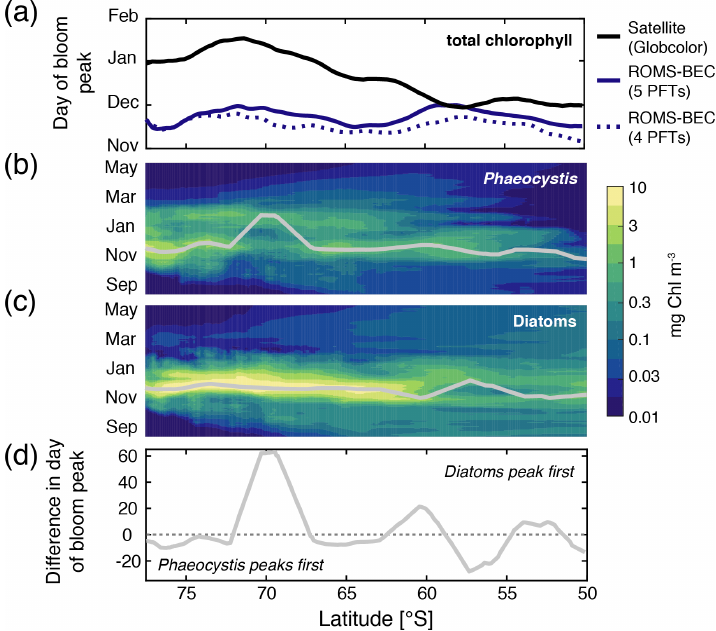
Figure 3. Hovmöller plots south of 50 ◦ S of (a) the day of maximum total chlorophyll concentrations in a satellite product (black line; Globcolor climatology from 1998–2018 based on the daily 25km chlorophyll product; see Fanton d’Andon et al., 2009; Maritorena et al., 2010), the Baseline simulation of this study (solid blue line), and the Baseline simulation of Nissen et al. (2018) (dashed blue line; without Phaeocystis ) and daily surface (b) diatom and (c) Phaeocystis chlorophyll biomass concentrations (mgchlm − 3 ). Overlain are the average days of the peak concentrations for each latitude (see also Sect. 2.3.1). Panel (d) denotes the difference in days in the timing of the bloom peak of diatoms and Phaeocystis for each latitude, with negative values denoting a succession from Phaeocystis to diatoms throughout the